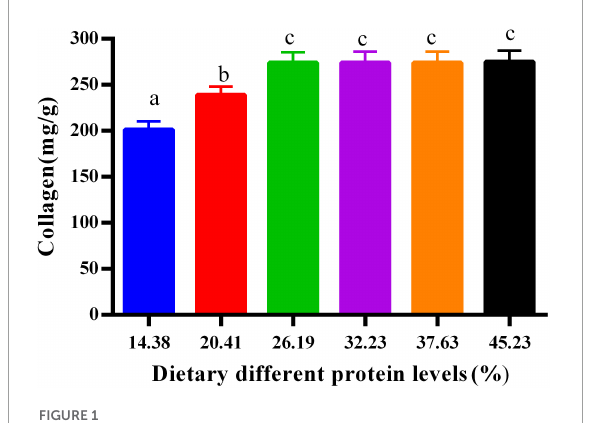
FIGURE1 Collagen in the calipash of juvenile softshell turtles fed a gradient of dietary supplementary protein levels for 8 weeks. Bars with different letters indicate significant differences among the groups ( P < 0.05). The values shown are the mean ± SD for three